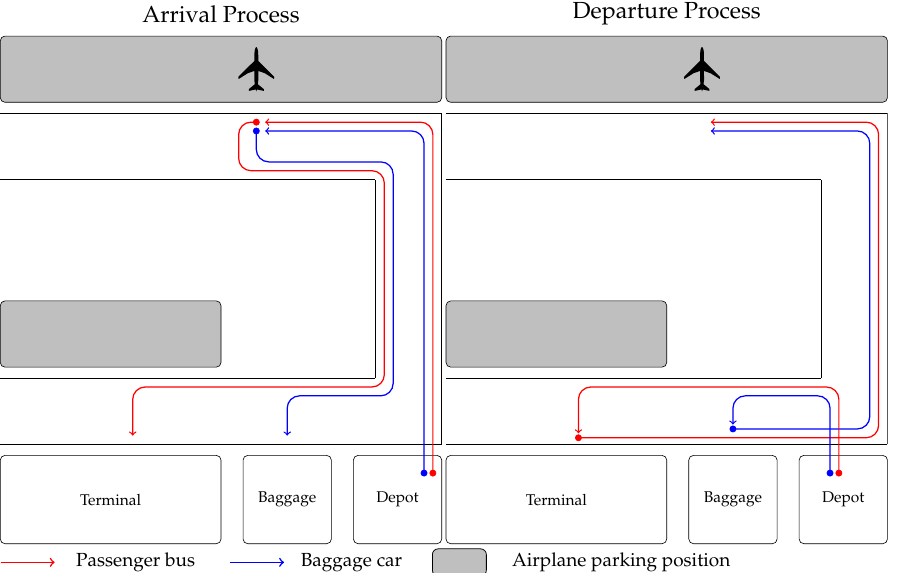
Figure 9. Operation of ground vehicles on an airport apron for the arrival process and departure process. To represent the state of charge of a vehicles’ battery, we assume that while a vehicle drives, it consumes energy and the battery charge level drops. When the vehicle moves along an ITU, the battery charge level increases unless the battery is full. If the vehicle’s battery is empty, it breaks